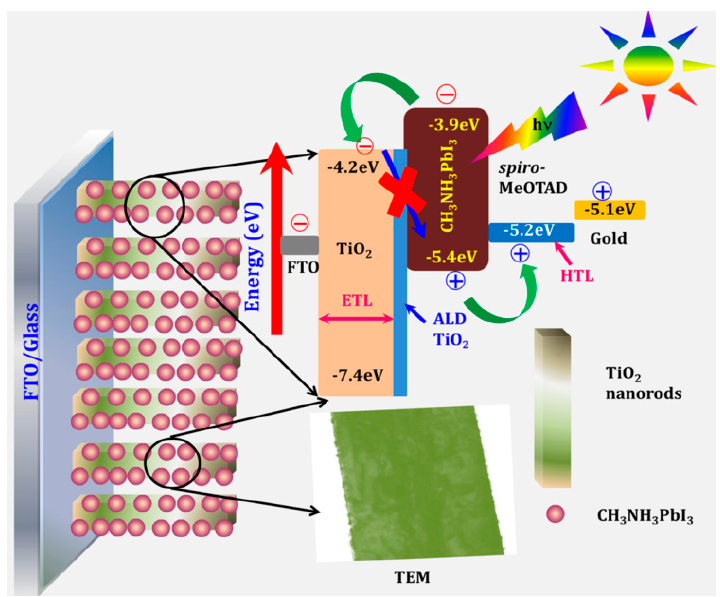
Figure 16. Schematic diagram of the energy level of 1D TiO 2 NR-PSCs. Reprinted with permission from [71]. Copyright 2015 American Chemical Society.